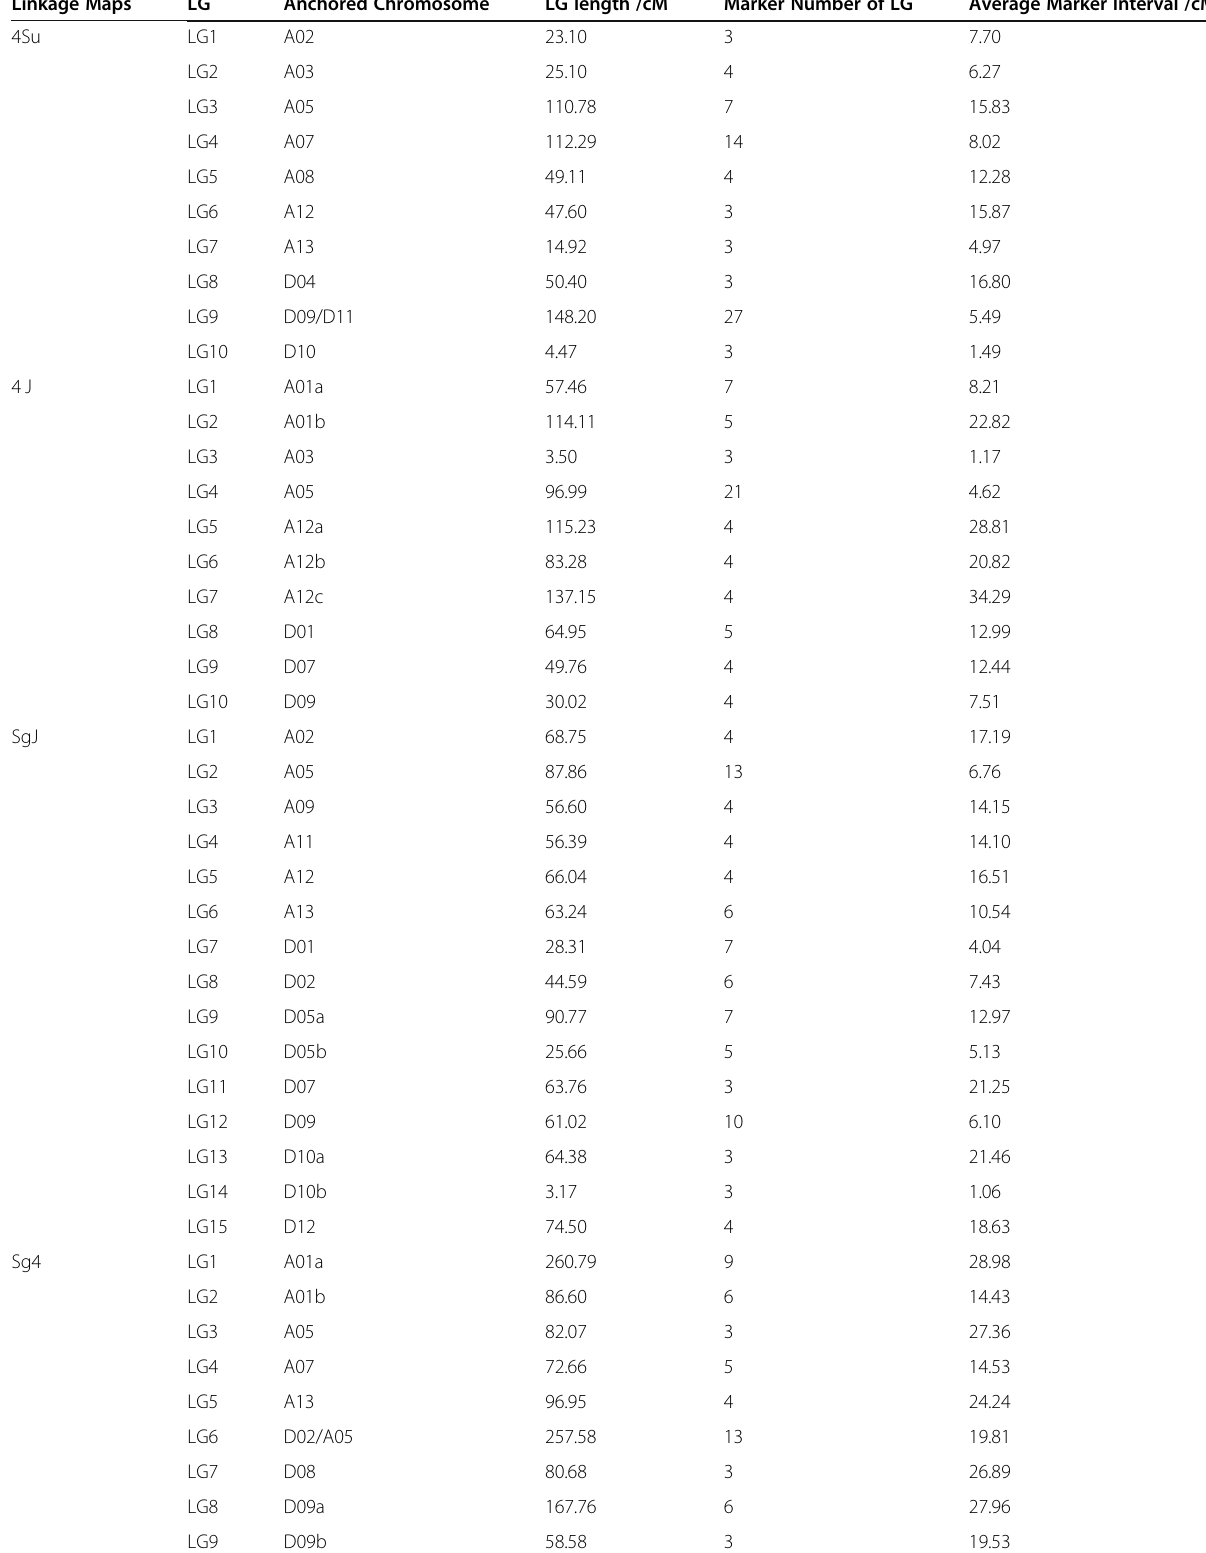
Table 2 Summary of 4 genetic linkage maps Linkage